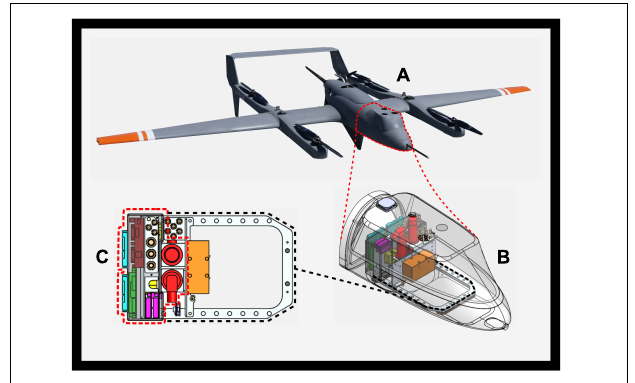
FIGURE 4 | (A) Image of the Latitude Engineering HQ-60 UAV with propellers for both flying and for vertical take-off and landing (VTOL). (B) Profile view of the HQ-60 modular nose cone and lid, with the skin transparent to reveal the Base payload acquisition system mounted inside. (C) Top view of the Base payload within the red-dash line and its square bracket within the black-dash line indicating available mounting holes for the modular ATOM, VNIR, RAD, and DD µ D payloads (the Base payload consists of the power supply, imagery DVR, GPS, IMU, and up-and-down looking IR pyrometers).